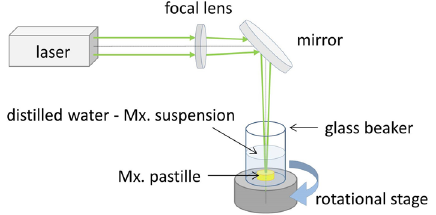
Figure 1. Experimental setup for pulsed laser ablation in liquid